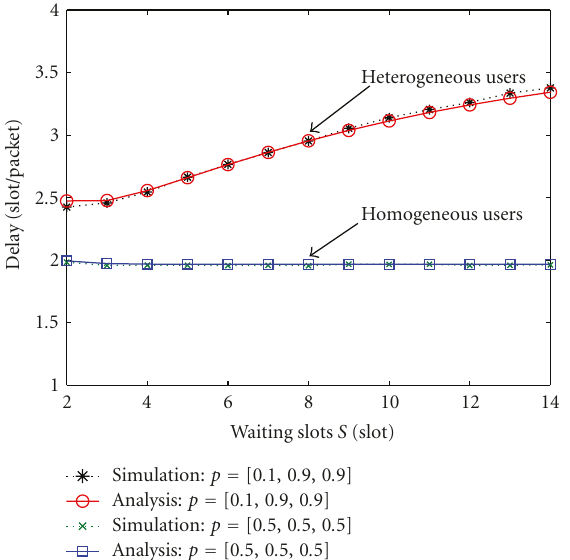
Figure 5: Throughput performance comparison between MGPQ and